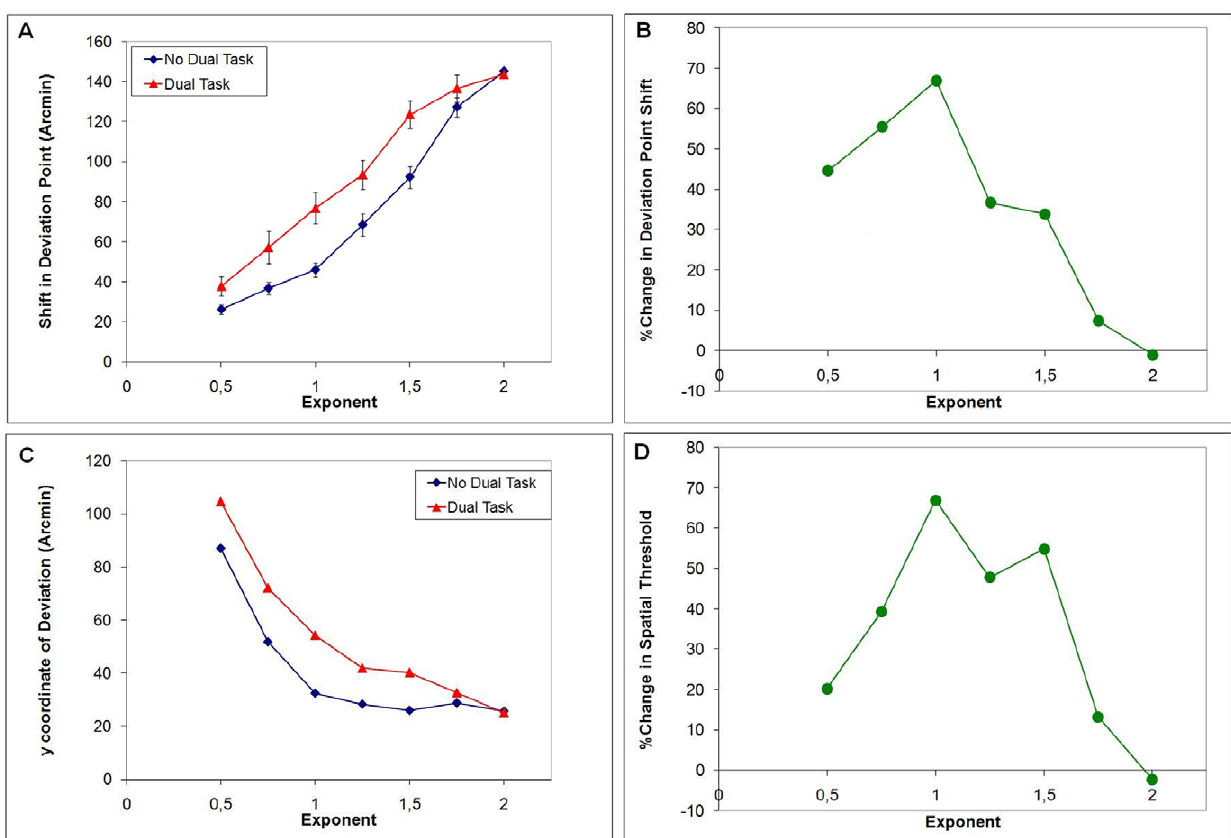
Figure 9. Results of Experiment 3. A . Shift in deviation point vs. exponent of the trajectory for two attention conditions. The perceived shift in deviation point monotonically increases with the exponent. Dual task condition has larger shifts in general. Error bars represent 6 1 SEM. B . The percent change in deviation point shift (%change due to dual task) is plotted against the exponent. The percent increase in the illusory position shifts due to dual task is more pronounced for intermediate exponents. C. The spatial thresholds computed from Figure 9A via the formula suggested in Figure 8B. D. The percent change in y axis spatial threshold due to dual task. Attention improves the spatial threshold mainly for intermediate deviation angles.